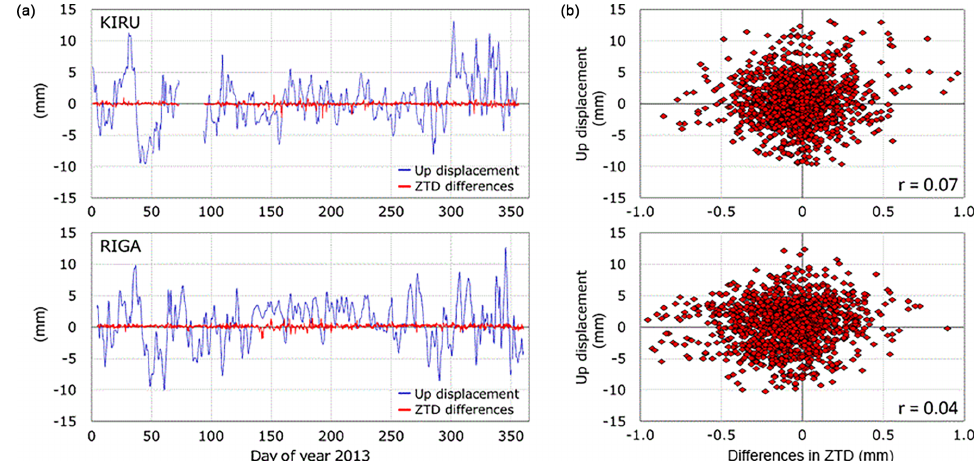
Figure 4. (a) Time series of the ZTD and up component differences between two time series obtained with and without non-tidal atmospheric loading for two EPN stations: KIR0 (Kiruna, Sweden) and RIGA (Riga, Latvia). (b) Scatter plots between these two parameters.